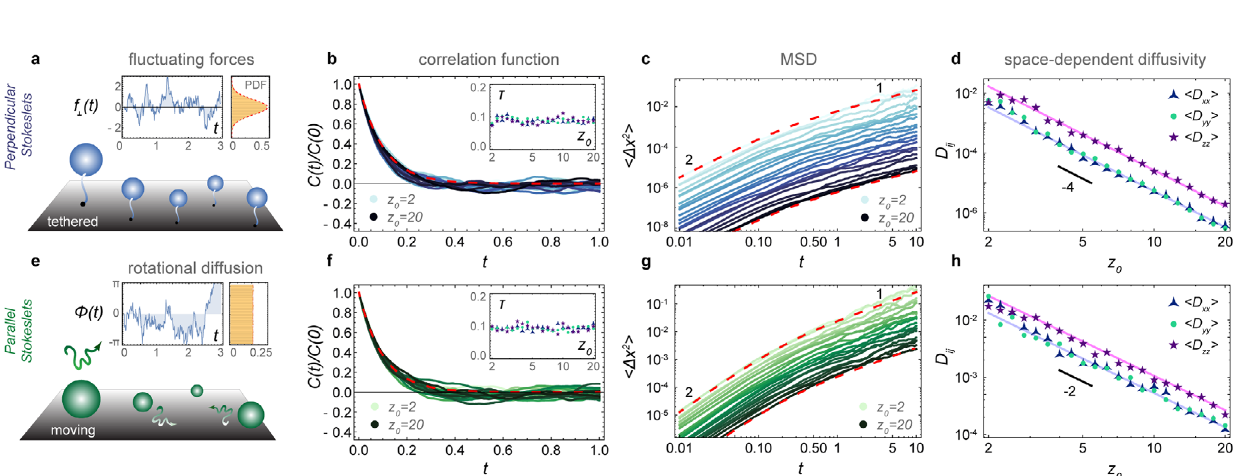
The columns correspond to different types of hydrodynamic actuators: we consider point forces (Stokeslets) oriented parallel to the surface, perpendicular Stokeslets, parallel dipoles, and rotlets. The rowscorrespondto differentmoments of thetotal fl ow velocity:weconsiderthe mean,thevariance,the skewness,andthe kurtosis of these fl ows,presentedas ðh v γ x i ; h v γ y i ; h v γ z iÞ usingtheexponent γ = 1, 2, 3, 4 respectively, as a function of distance from the carpet, z 0 . Note that the off-diagonal components are equal to zero in all cases.